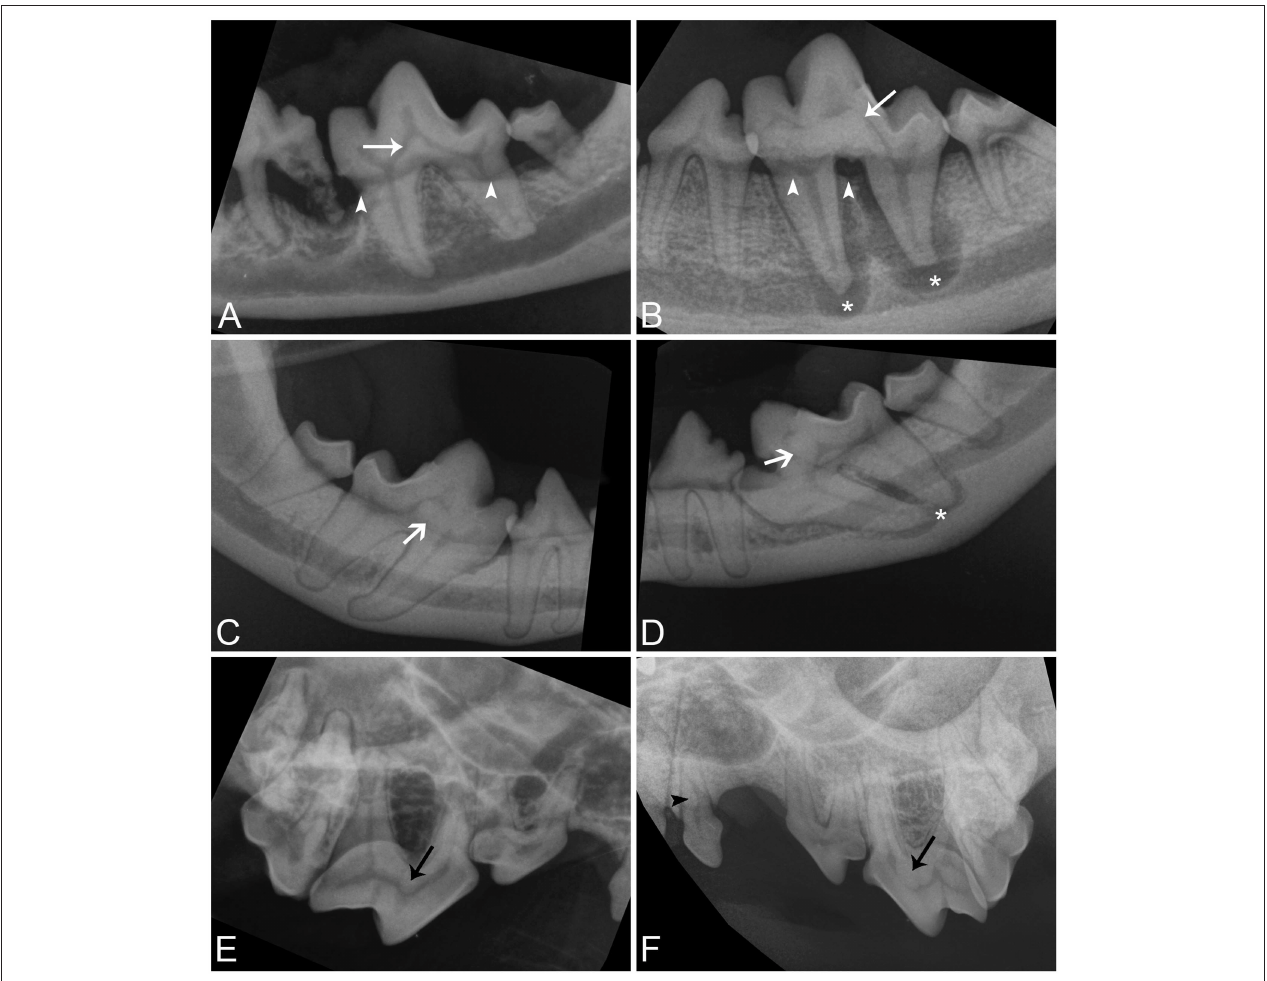
FIGURE 1 | Intraoral radiographic images of affected teeth. (A,B) Parallel radiographs of the left mandibular first molar tooth from dog 5 and 1, respectively, demonstrating the variation in size of abnormal tissue on the floor of the pulp chamber (white arrows). (C,D) Parallel radiographs of the right and left mandibular first molar teeth from dog 3, respectively, demonstrating asymmetry in the location of lesions and conformational abnormalities (white open arrows). Both mandibular first molar teeth are mesioverted and under-erupted bilaterally. The abnormal tissue of tooth is centered on the floor of the pulp chamber in the right mandibular first molar tooth but is centered on the mesial wall of the pulp chamber in the left mandibular first molar tooth. (E,F) Bisecting angle radiographs of the caudal right maxilla of dog 6 and the caudal left maxilla of dog 1 demonstrating abnormal tissue on the floor of the pulp chambers of the maxillary fourth premolar teeth (black arrows), and a pulp stone in the left maxillary first premolar tooth in dog 1 (black arrowhead). Periapical lucencies ( B,D —white asterisk), and alveolar bone loss ( A,B —white arrowheads) affect some